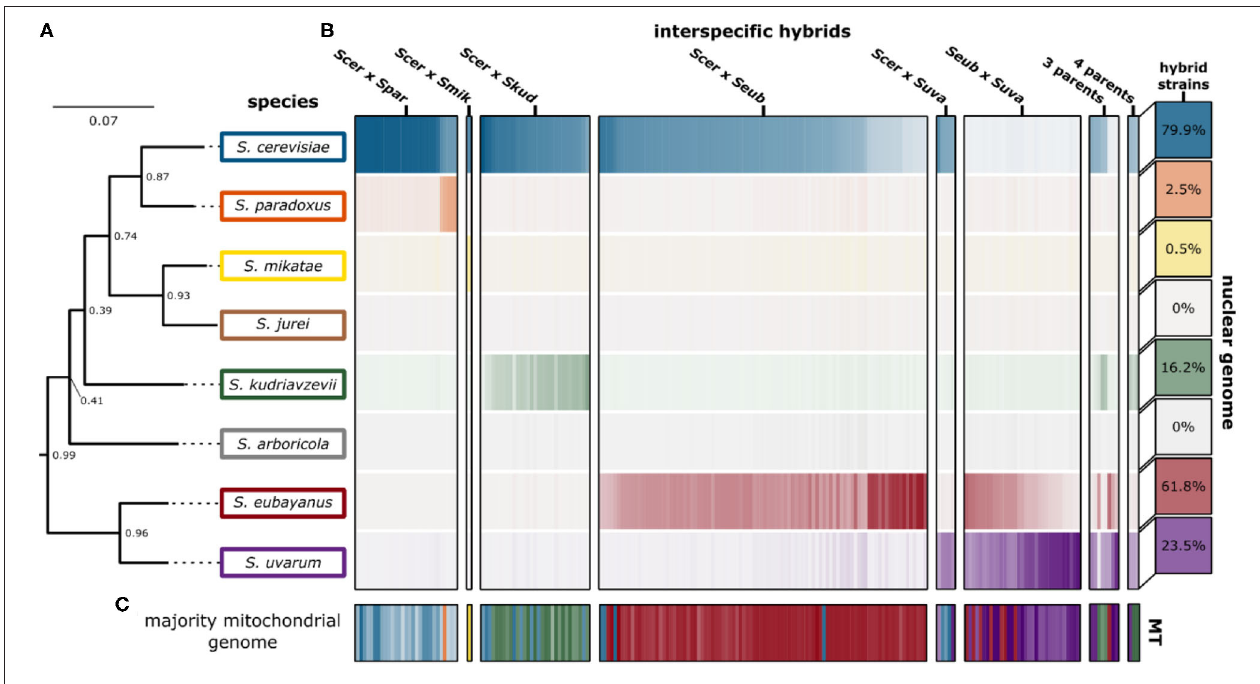
FIGURE 3 | Genetic ancestry of interspecific hybrids. (A) The phylogenetic tree indicates the phylogenetic relationship of the eight Saccharomyces species. The support values indicate the proportion of times that the bipartition is seen in each of the individual species tree estimates. Branch lengths represent the average number of substitutions per site across the sampled gene families. (B) Genomic contributions are calculated as the proportion of reads mapping to a representative of each species. The 204 interspecific hybrid strains span the horizontal axis, with the genomic contribution of each hybrid strain indicated. The intensity of each color indicates the genomic contribution for each species, with low (white) and high intensity indicating low and high genomic contributions, respectively. The percentage of hybrid strains in this study ( n = 204) with significant genomic contributions from each Saccharomyces species is indicated in boxes on the right. (C) The majority mitochondrial genome within each hybrid strain is shown with similar coloring. Mitochondrial genome contributions from each species are shown in Supplementary Figure 4